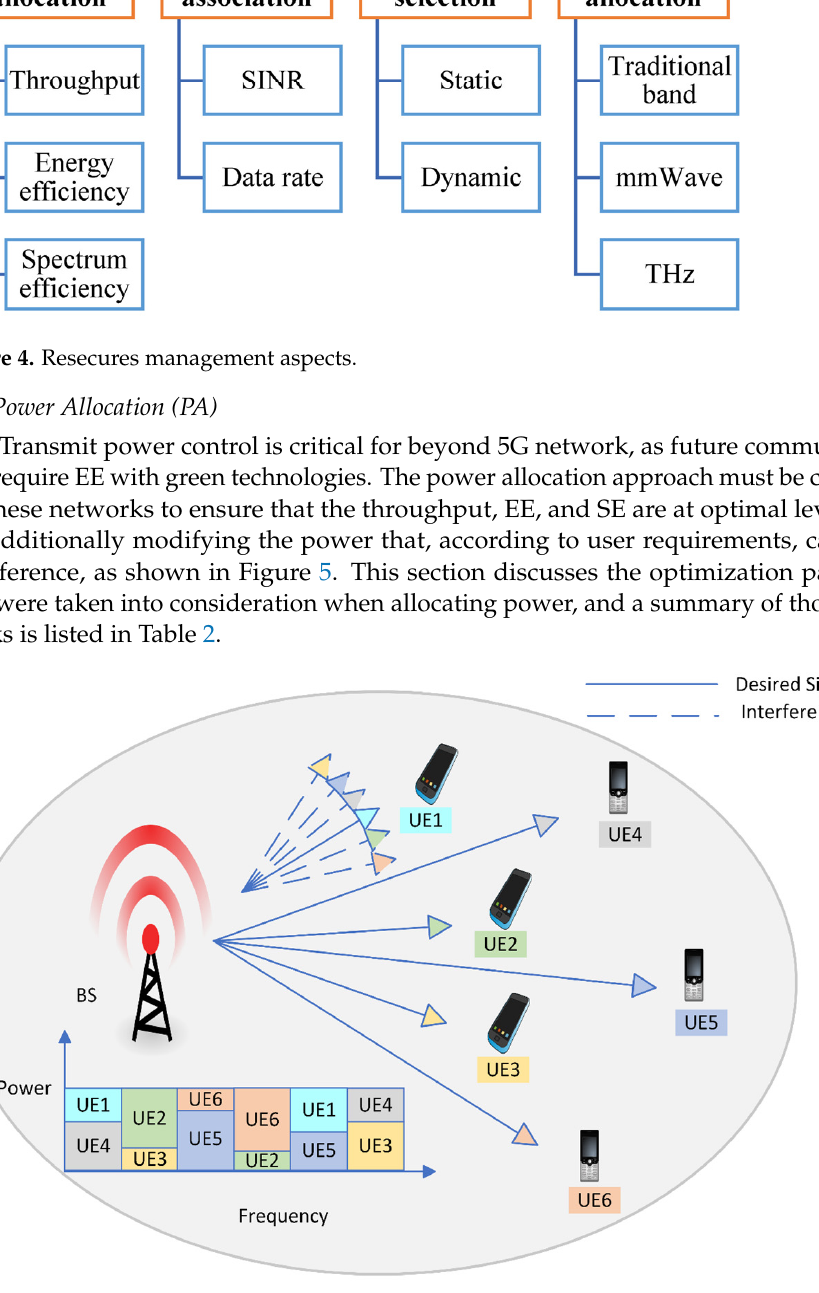
Figure 5. Power allocation in HetNet. Table 2. Summary of the related work for power allocation.